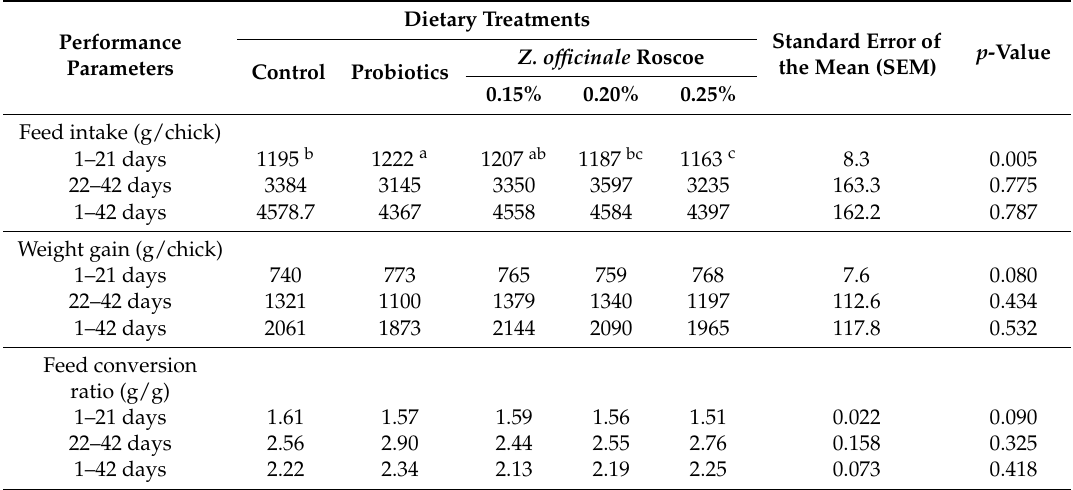
Table 2. Effect of experimental diets on performance parameters of broiler chickens.